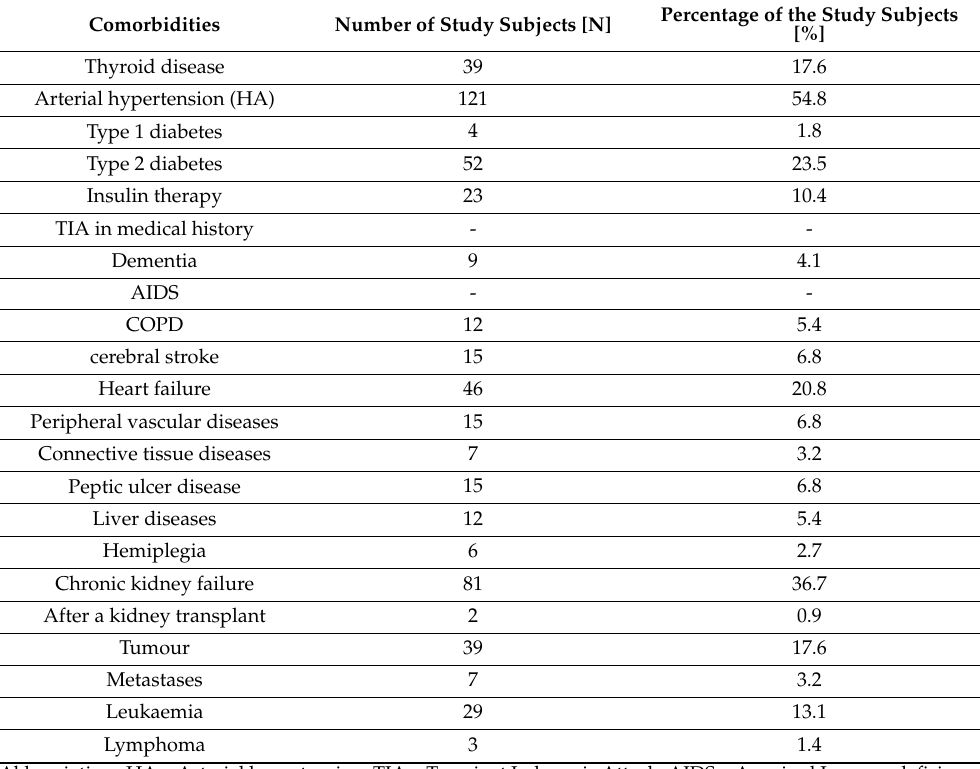
Table 3. Comorbidities of the patients in the studied